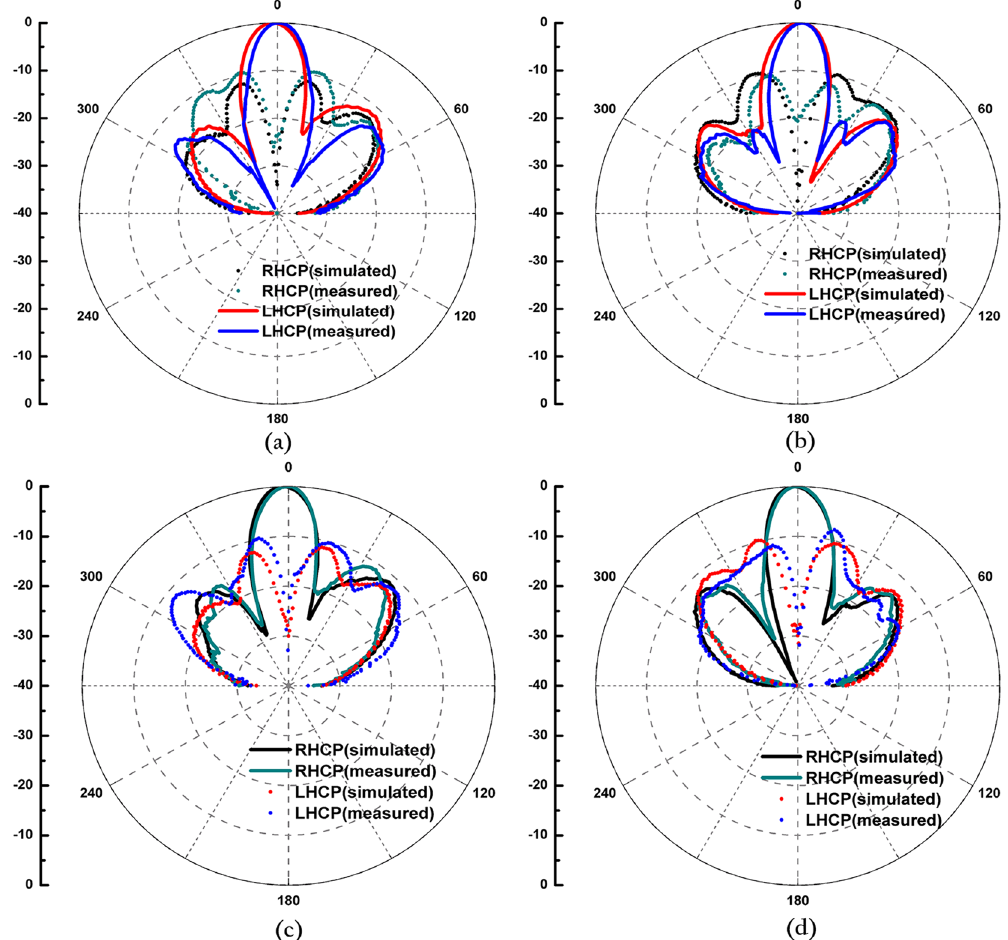
Figure 6. Simulated and measured radiation patterns of the LHCP antenna in the ( a ) X–Z and ( b ) Y–Z planes and the RHCP antenna in the ( c ) X–Z and ( d ) Y–Z planes at 10